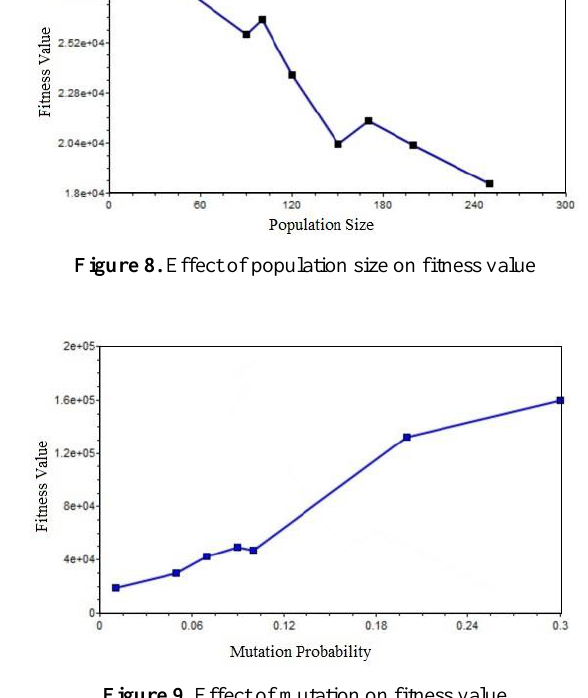
Figure 9. Effect of mutation on fitness